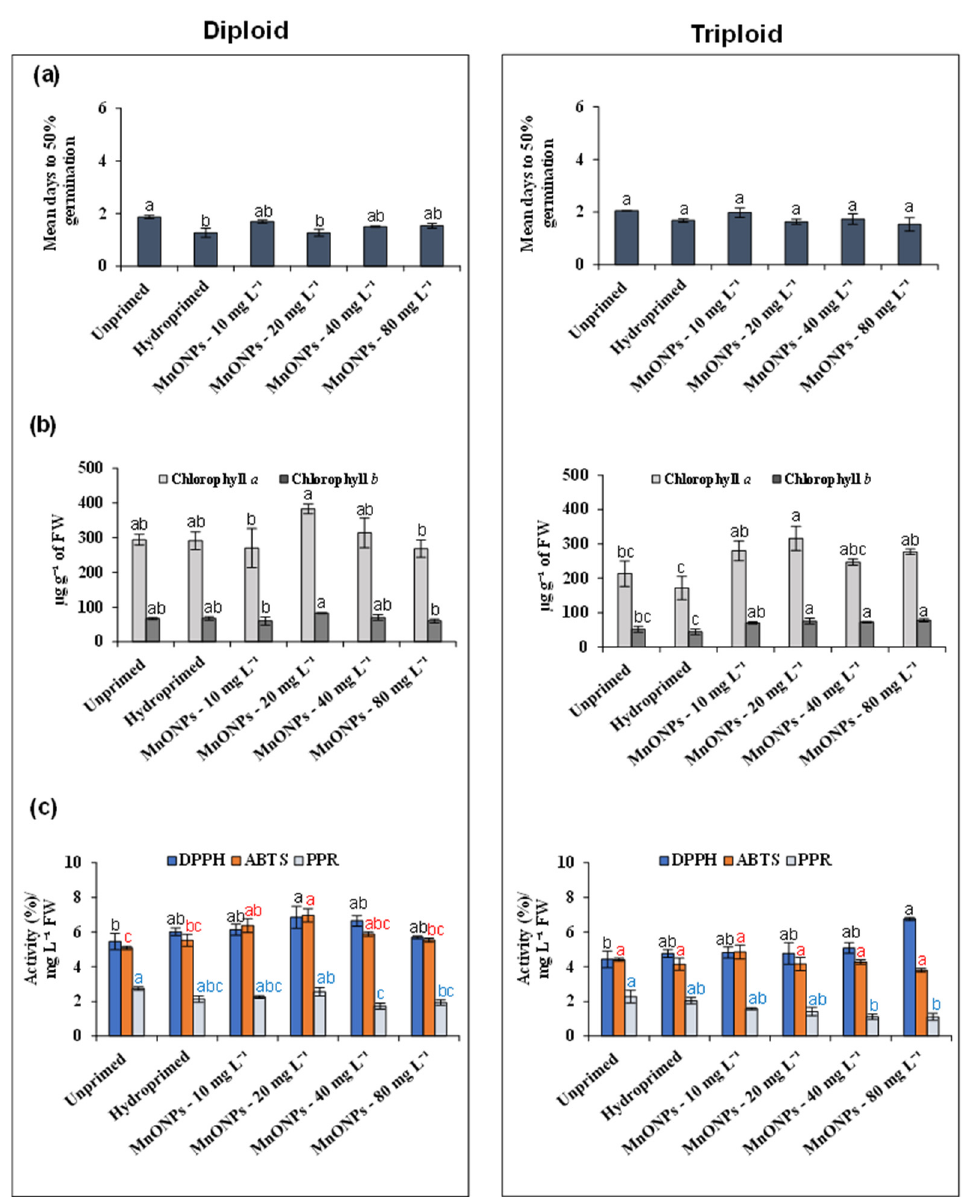
Figure 3. Effect of different MnO-NPs seed priming treatments on mean days to reach 50% germination ( a ), chlorophyll contents ( b ), and antioxidant activities ( c ) in diploid and triploid watermelon seedlings. The post hoc test significant based differences ( p < 0.05) among different groups and assays are shown by different letters and